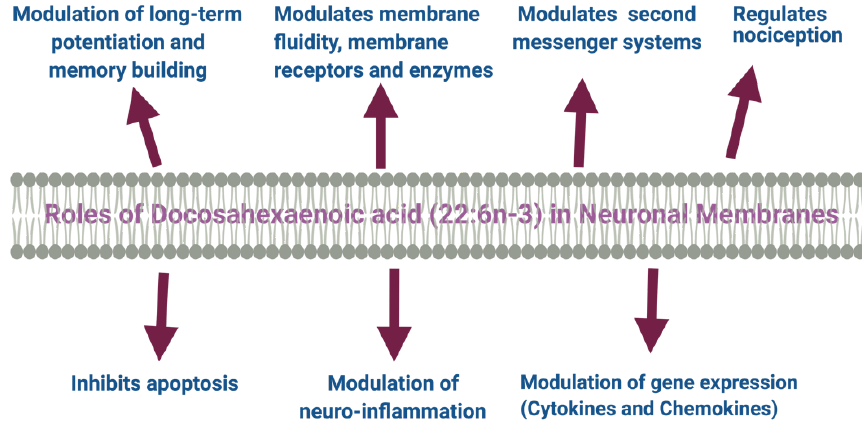
Figure 1. DHA modulates several aspects of structural and functional activities of neuronal mem-